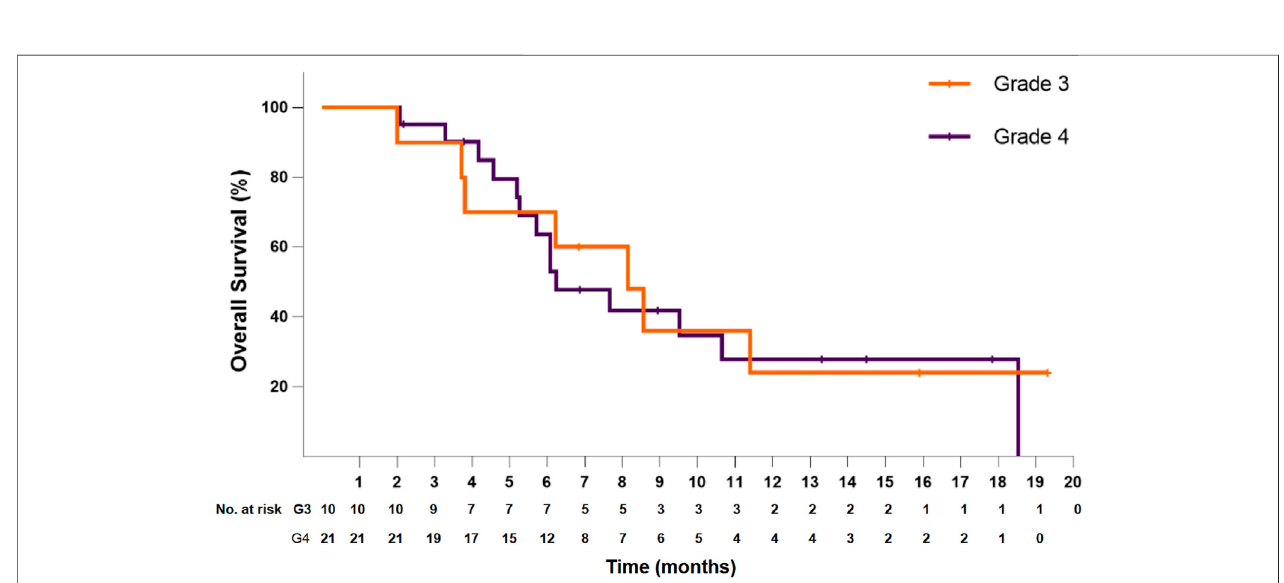
FIGURE 4 | Kaplan – Meier plot of overall survival for patients with grade 3 (orange) or grade 4 (violet) disease.